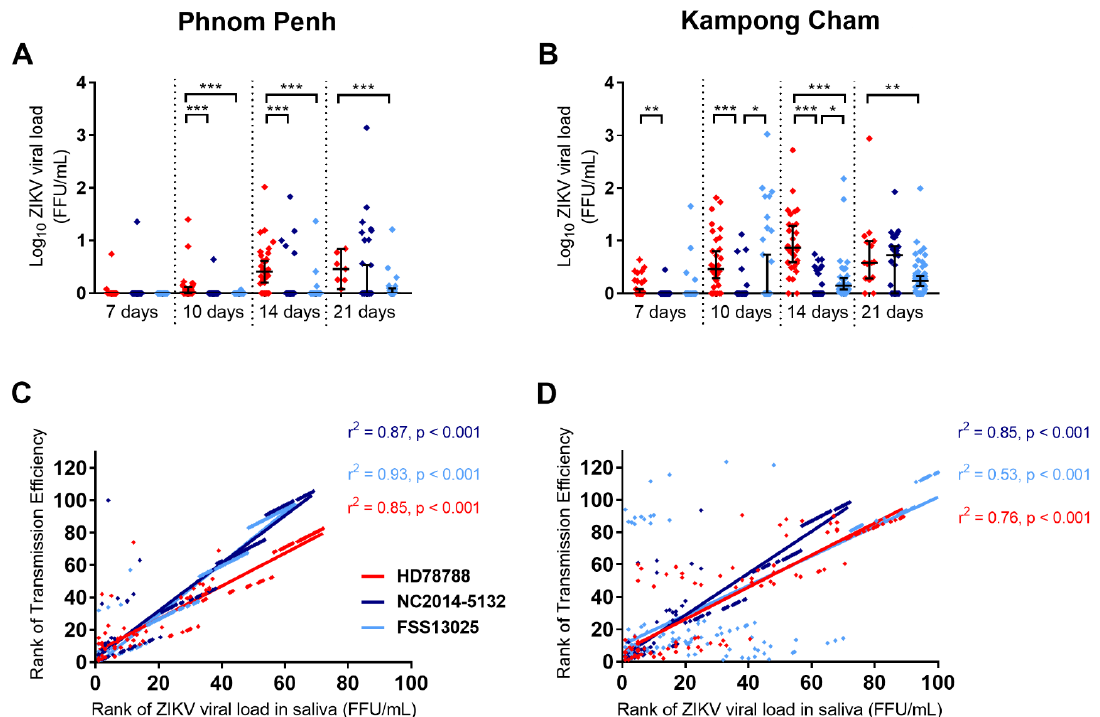
Figure 3. Viral load in the saliva of Ae. aegypti mosquitoes. Ae. aegypti populations from Phnom Penh ( A , C ) and Kampong Cham ( B , D ) were infected with ZIKV HD78788 (red), NC-2014-5132 (dark blue), or FSS13025 (light blue). The viral loads in saliva ( A , B ) were determined by RT-qPCR and the individual results are plotted with a median and 95% CI. Statistical differences determined with Kruskal–Wallis test (Dunn’s multiple comparison correction) are marked by asterisks: * p < 0.05, ** p < 0.01, and *** p < 0.001. Correlation between the transmission efficiency and viral loads in saliva were evaluated by the Spearman correlation analysis ( C , D ).